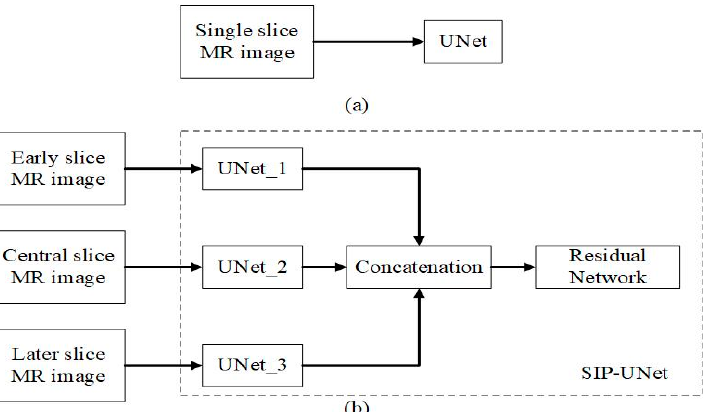
Figure 3. Illustration of procedure for: ( a ) typical UNet and ( b ) proposed SIP-UNet.